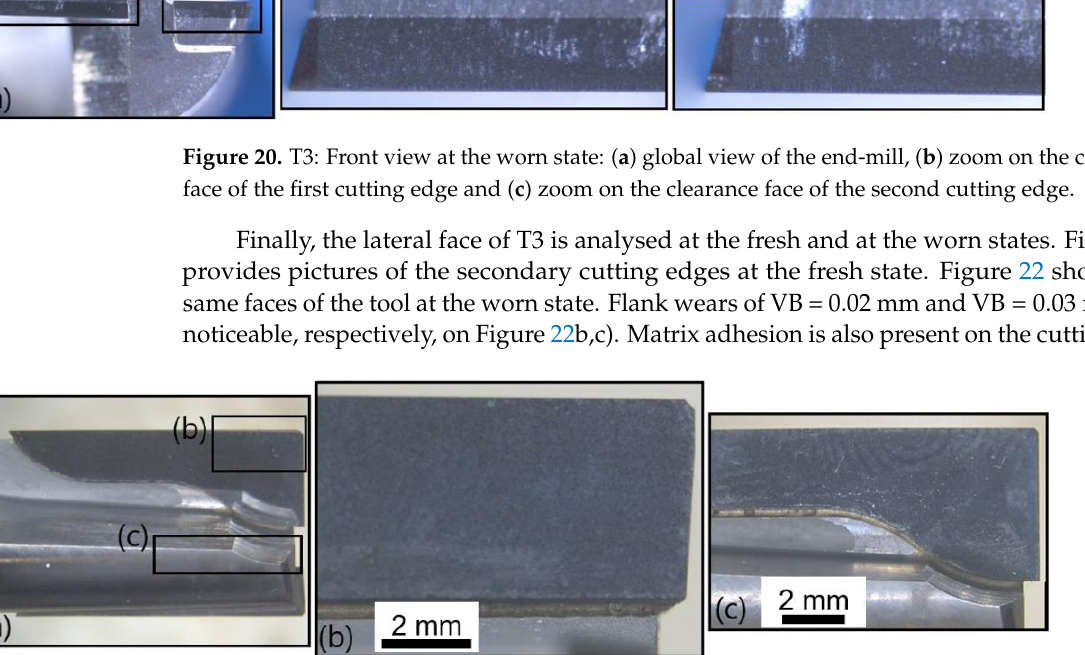
Figure 21. T3: Lateral view at the fresh state: ( a ) global view of the end-mill, ( b ) zoom on the clearance face of the first cutting edge and ( c ) zoom on the clearance face of the second cutting edge.